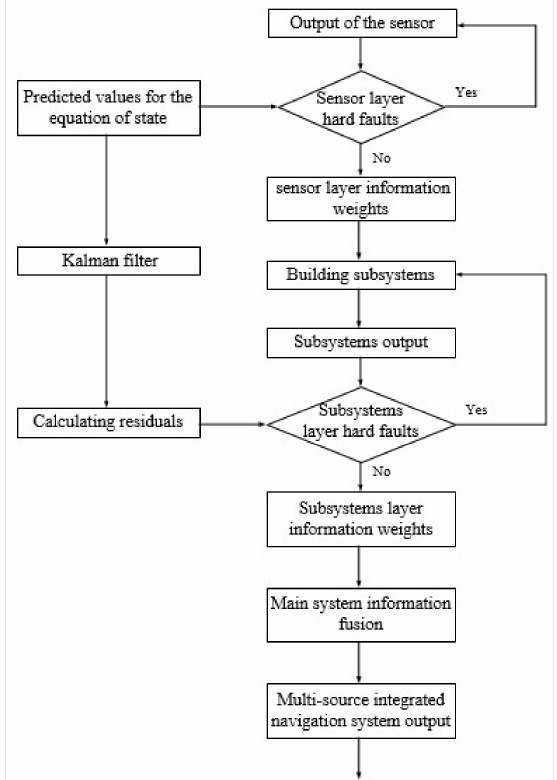
Figure 6. Flow chart of multi-source fault-tolerant robust filtering algorithm based on informa- tion evaluation.